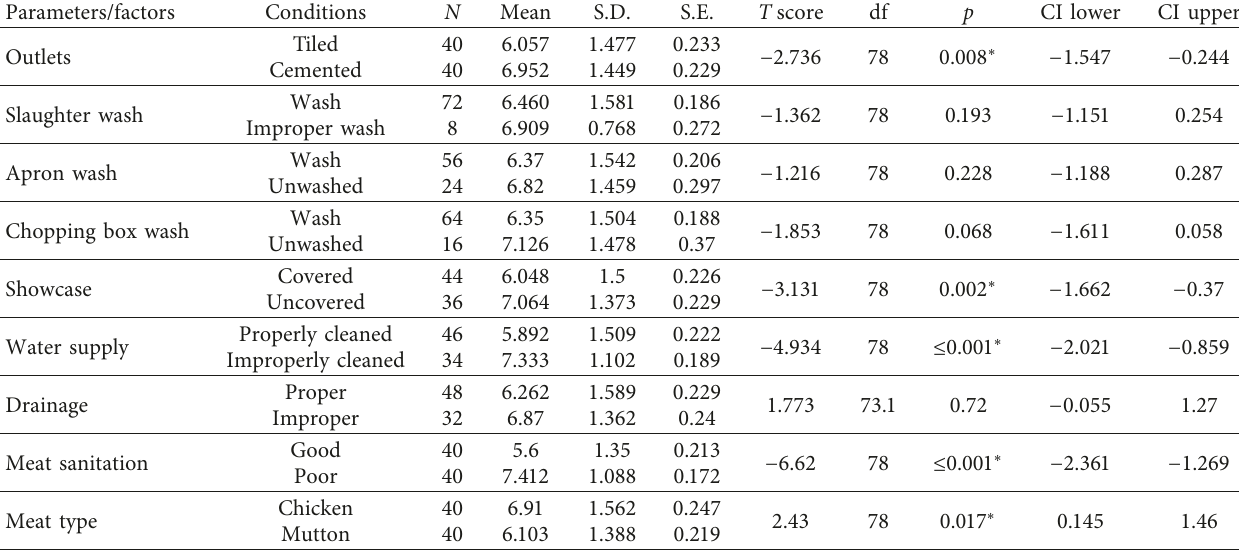
Table 11: Independent sample T -test of mean of TVC in meat against several sanitation parameters and meat type.